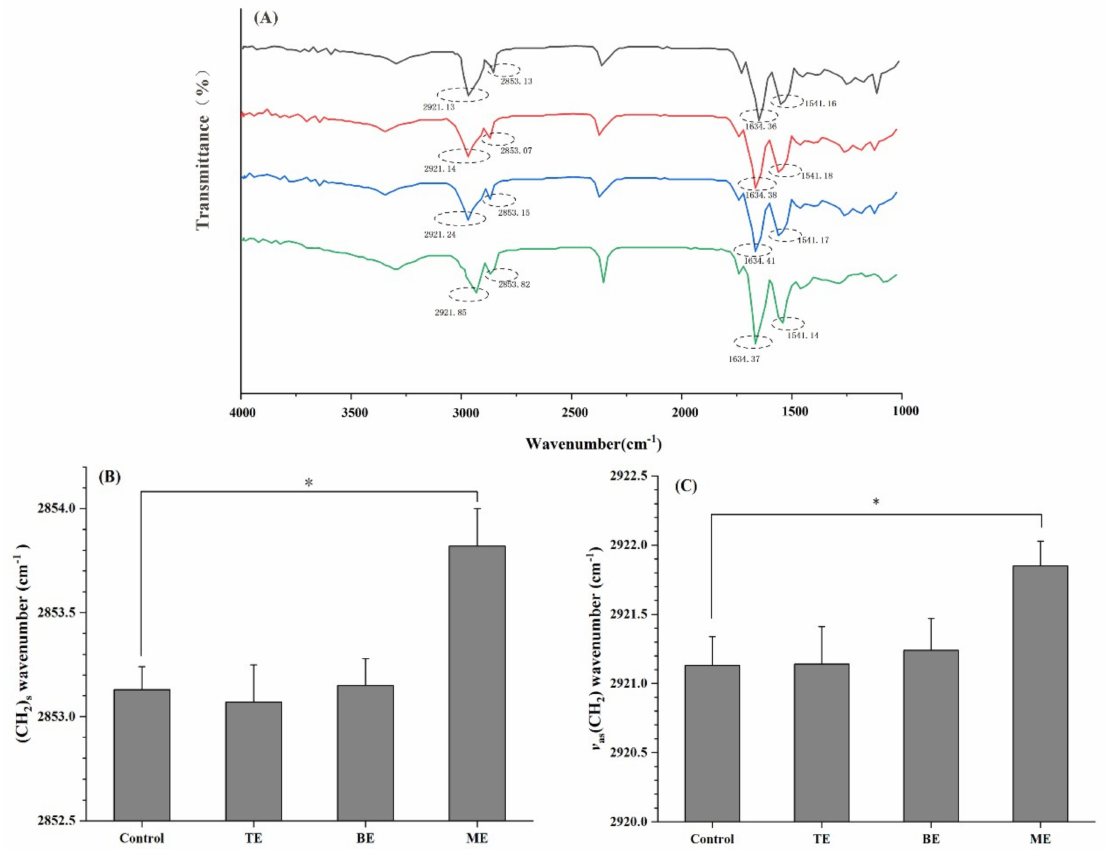
Figure 5. ATR-FTIR investigation. ( A ) ATR-FTIR transmission spectra of rabbit skin treated with TE (red), BE (blue), ME (green), and saline (black, as control). ( B , C ) Wavenumbers of symmetric and asymmetric methylene stretching of SC lipids. Mean ± SD, n = 4; * Statistically significant di ff erence compared to the respective control at p <